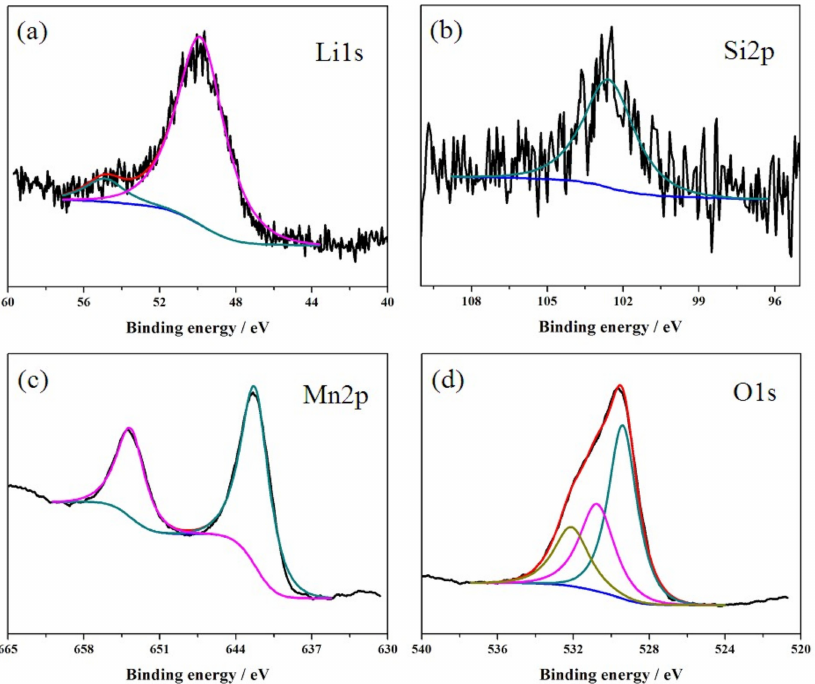
Figure 4. XPS spectra of Li1s ( a ), Si2p ( b ), Mn2p ( c ) and O1s ( d ) in the LiSi 0.05 Mn 1.95 O 4